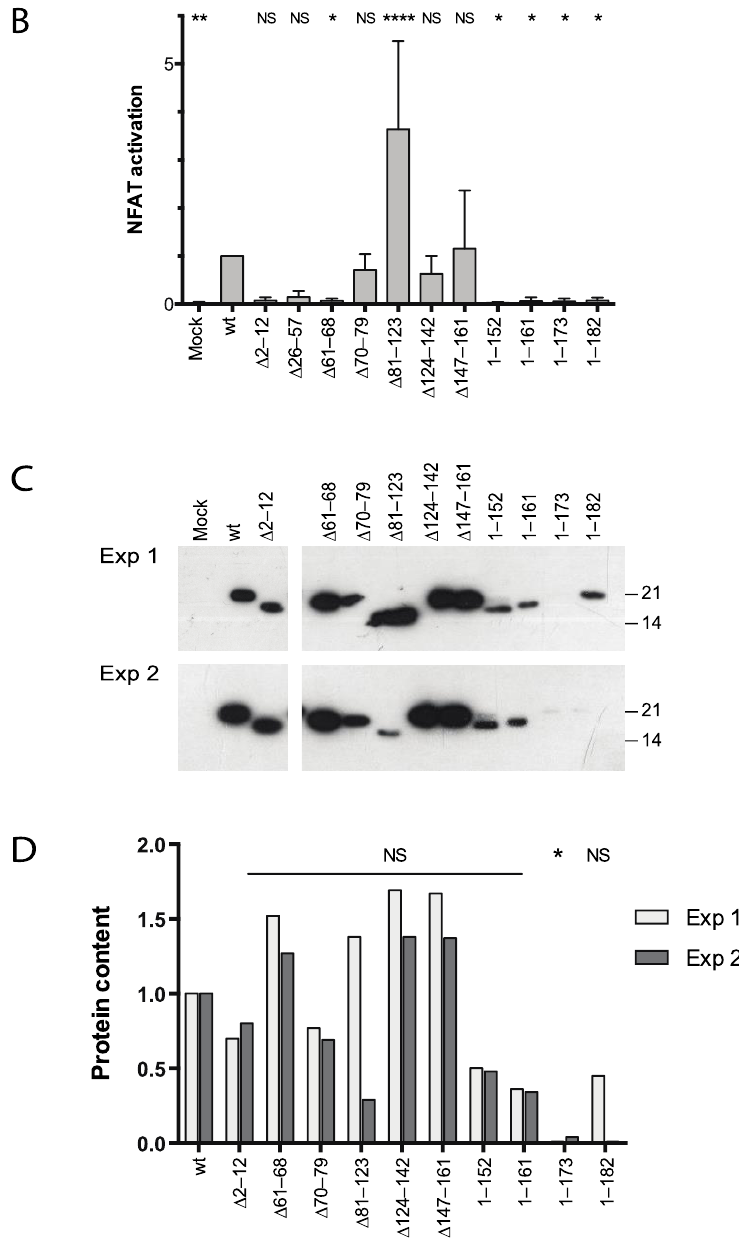
Figure 1. Activation of NFAT by HCV C deletion mutants. ( A ) Schematic representation of the HCV Core ( C ) protein domains and deletion mutants. The C protein is divided into 3 domains, D1, D2 and D3. Based on the distribution of charged amino acid, D1 is further subdivided into three basic domains, BD1, BD2 and BD3. D2 comprises two amphipathic alpha-helices helix 1(H1) and helix 2(H2) connected by a hydrophobic loop (HL). D3 is a transmembrane domain (TM) that contains signal sequences and is processed by host proteases. The first cleavage of the C protein at amino acid (aa) residue 191 by the host signal peptidase (SP) releases immature C protein (p23) of 191 aa. The second cleavage by ER resident signal peptide peptidase (SPP) releases the mature C protein (p21) of 177 aa. Different deletion mutants are generated by deleting the defined aa sequences in D1, D2 and D3 within the C protein as shown in the figure. Deletions are represented by ∆ and the number corresponds to the aa removed in the C protein deletion mutants. ( B ) Transcriptional activation